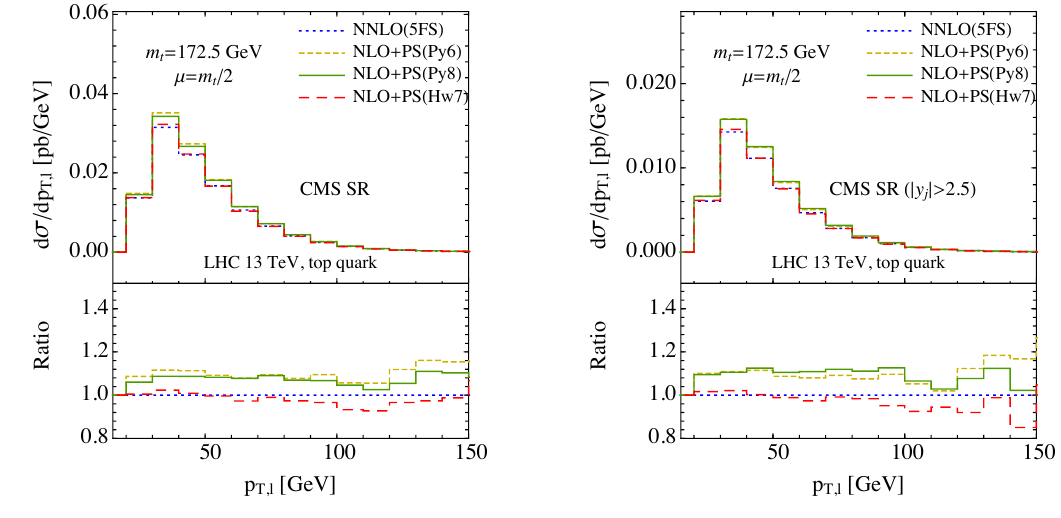
Figure 5 . Transverse momentum distribution of the charged lepton within the two fiducial regions, comparing predictions at fixed-order and those from various event generators in the 5FS for LHC 13